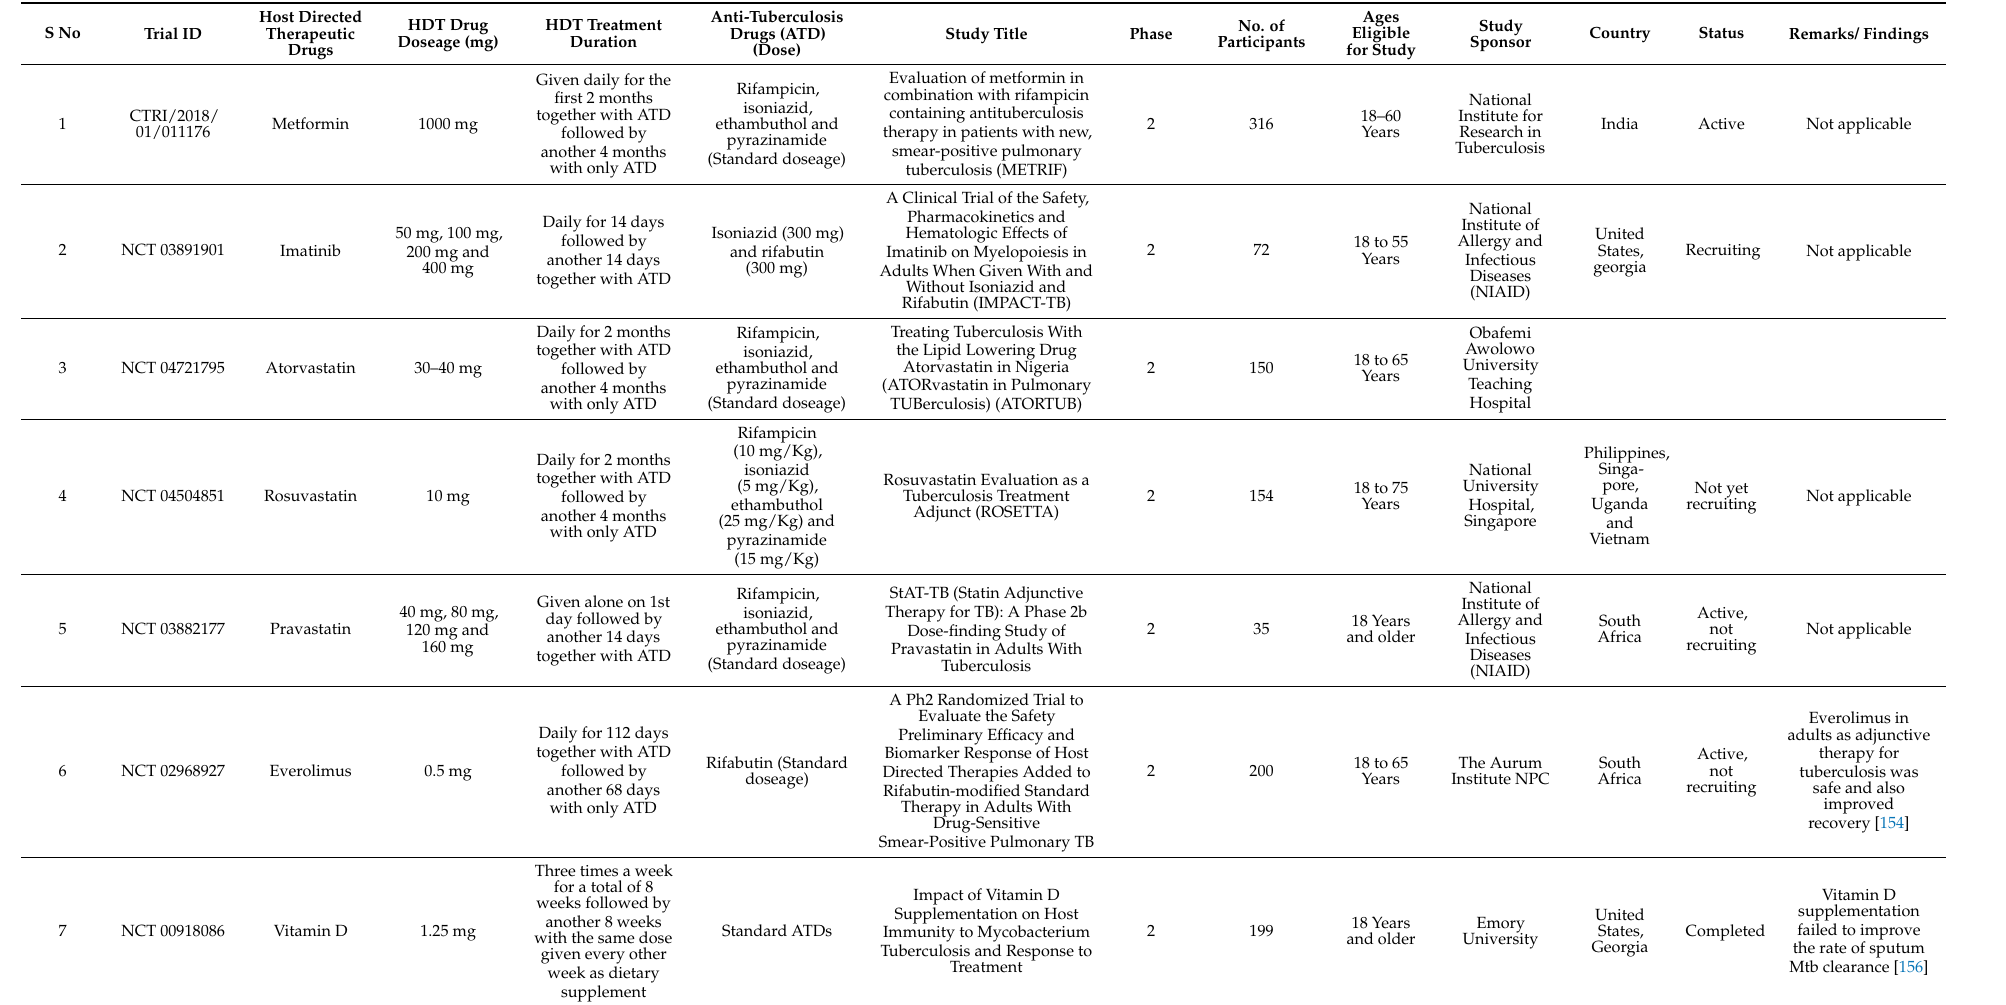
Table 2. Summary of the different host directed therapeutic drugs in clinical trialsfor the treatment of tuberculosis